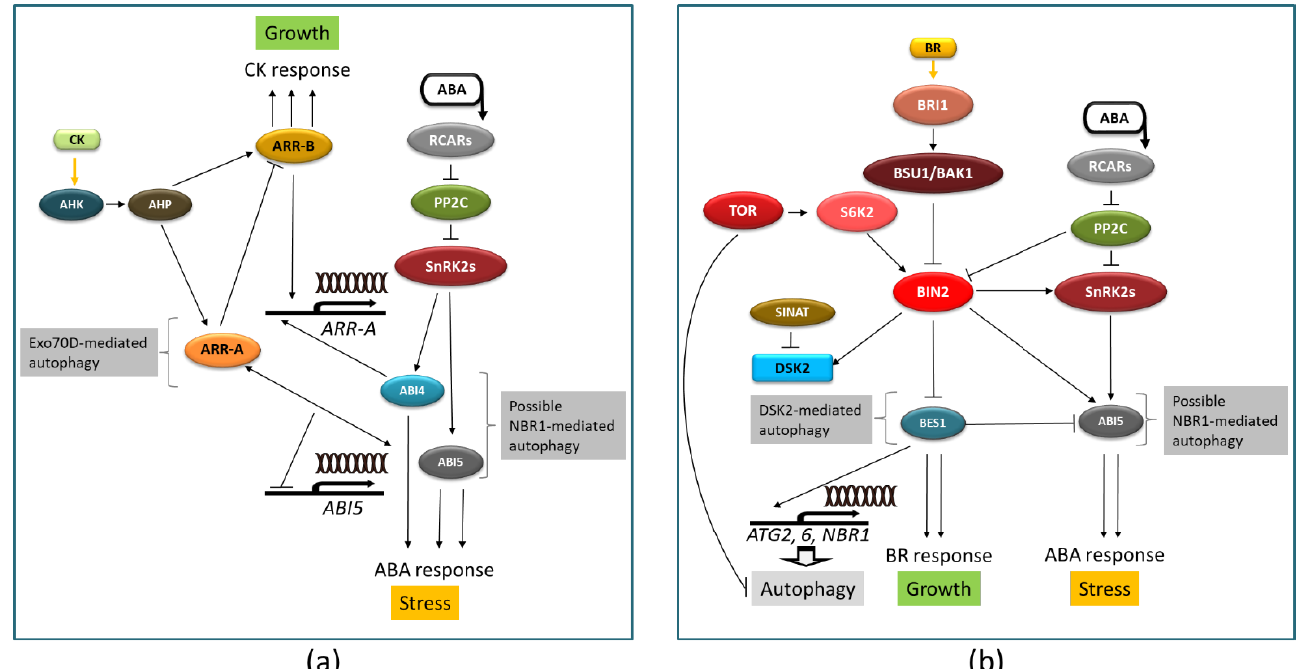
Figure 5. Interplay of autophagy with ABA–cytokinin crosstalk ( a ) and ABA–brassinosteroid crosstalk ( b ). Yellow arrows mark CK and BR signals. Elements of the CK signaling pathway (AHK, histidine kinase receptor(s); AHP, histidine phosphotransfer protein(s)) and BR signaling pathway (BRI1, leucine-rich repeat receptor-like kinase family; BSU1/BAK1, protein kinases; BIN2, GSK3-like kinase; BES1, transcription factor) are marked in panels A and B, respectively. See text for further details.